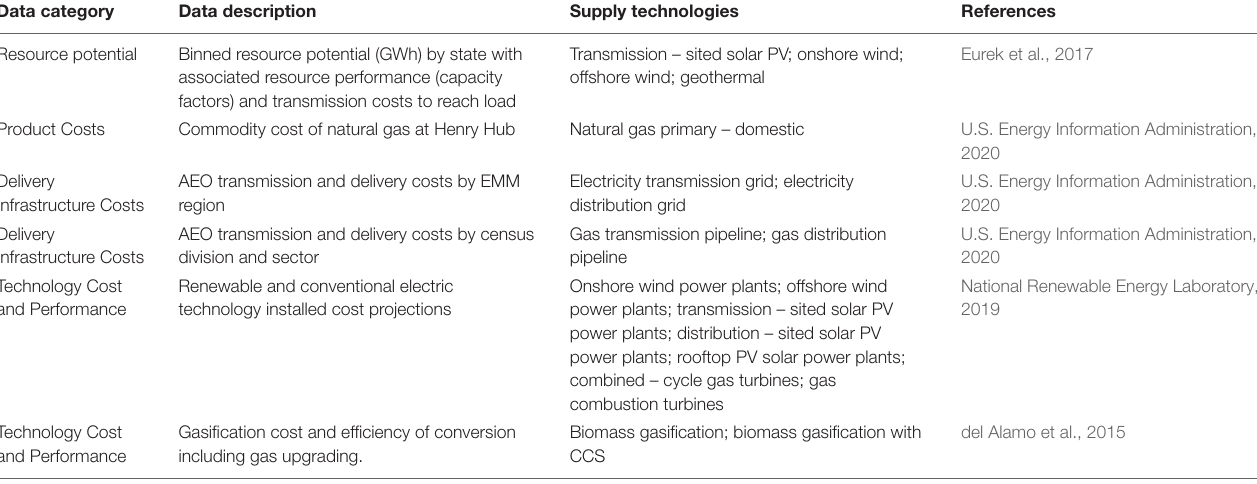
TABLE 1 | Resource and technology data sources.